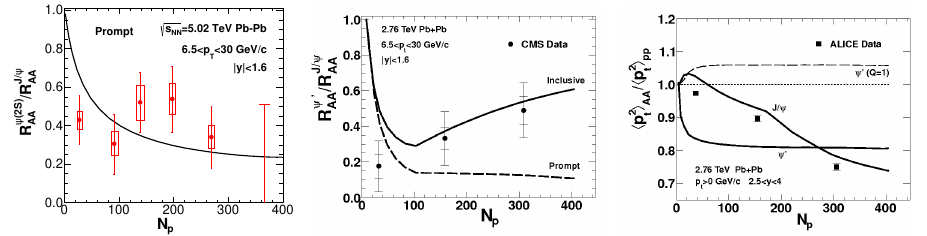
Figure 6. (Color online) The left panel is prompt R ψ (2 S ) TeV Pb-Pb collisions. The middle panel is prompt (dashed line) and inclusive (solid line) R ψ (2 S ) at √ s NN = 2 . 76 TeV. The decay rates for charmonia in left panel is updated compared with the middle panel. The right panel is from AAAA.